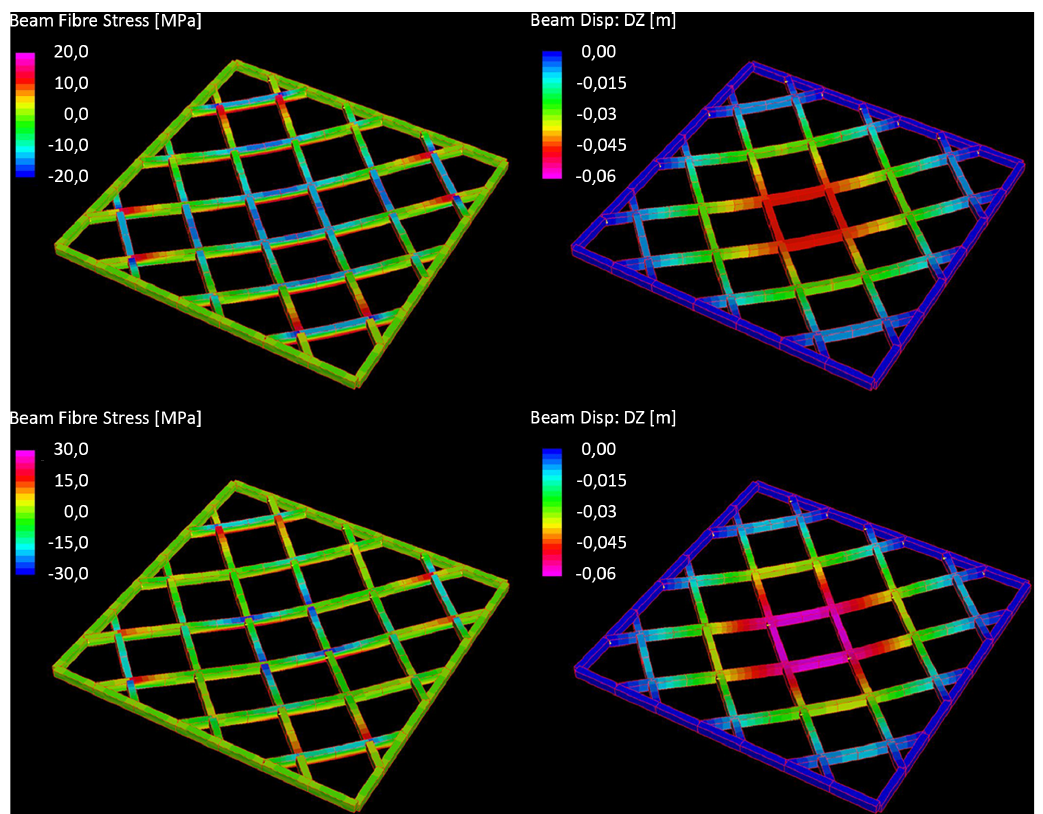
Figure 13: Top left: Stresses due to axial forces and bending moments (fibre stresses) in the continuous grid beams. Top right: beam displacements in vertical direction for the continuous beams grid. Bottom left: Stresses due to axial forces and bending moments (fibre stresses) in the reciprocal frame roof. Bottom right: beam displacements in vertical direction for the reciprocal frame